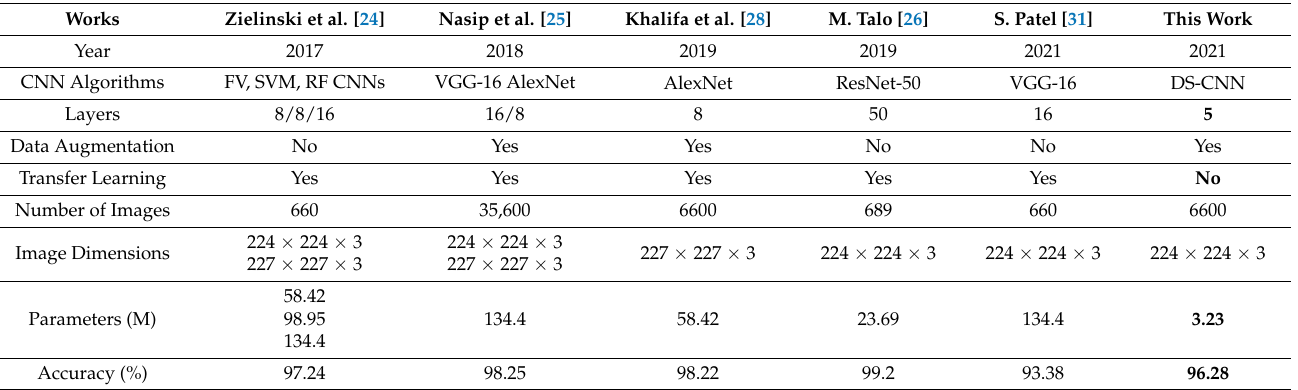
Figure 9. Recent state-of-the-art studies on DIBaS image classification. On the other hand, the parameters (3.23 M) and model size (five layers) of our design were the smallest. The optimization caused it to have convolutional computation and good data augmentation. This approach could pave the way for deep-learning algorithms to be integrated directly in low-resource devices in biomedical fields. Table 5. Comparative analysis among the studies conducted on the DIBaS